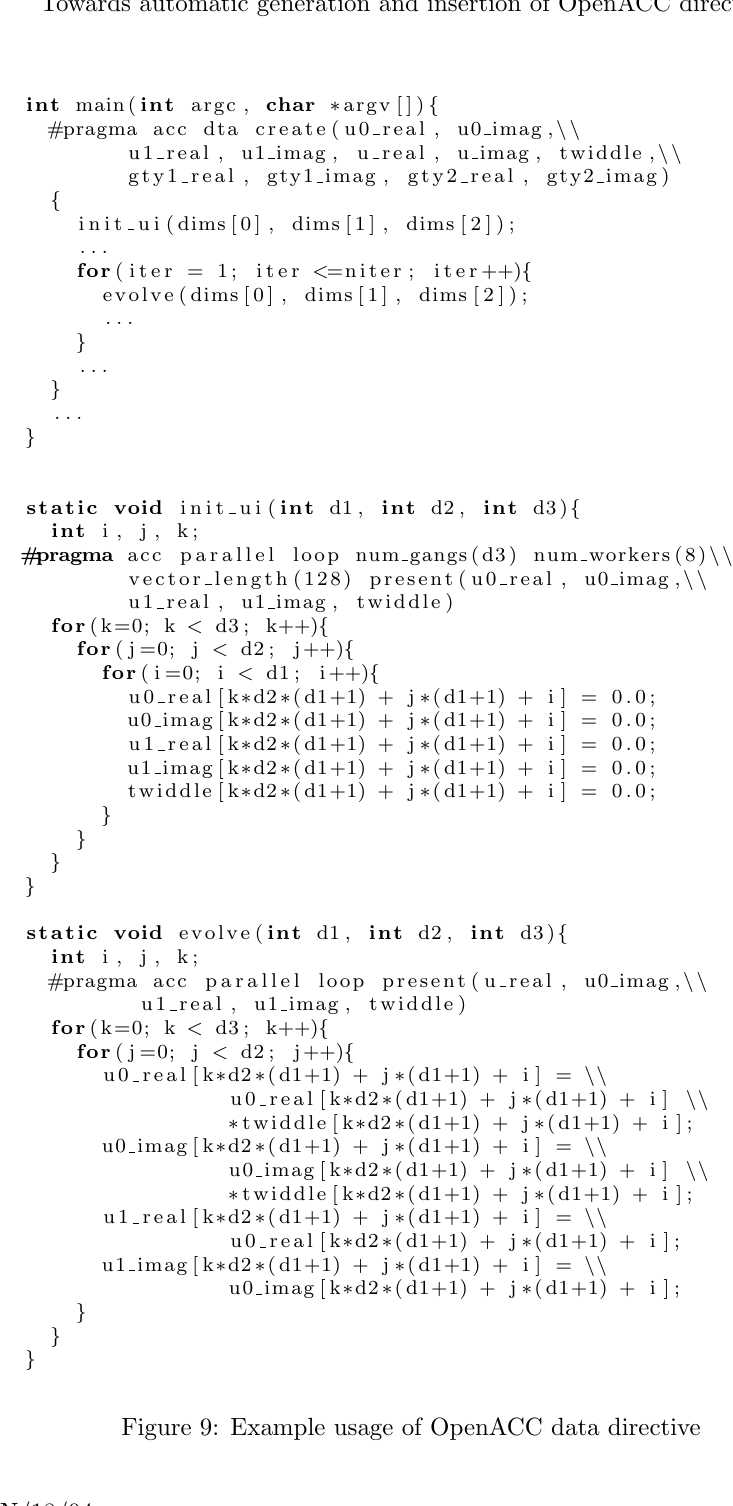
Figure 9: Example usage of OpenACC data